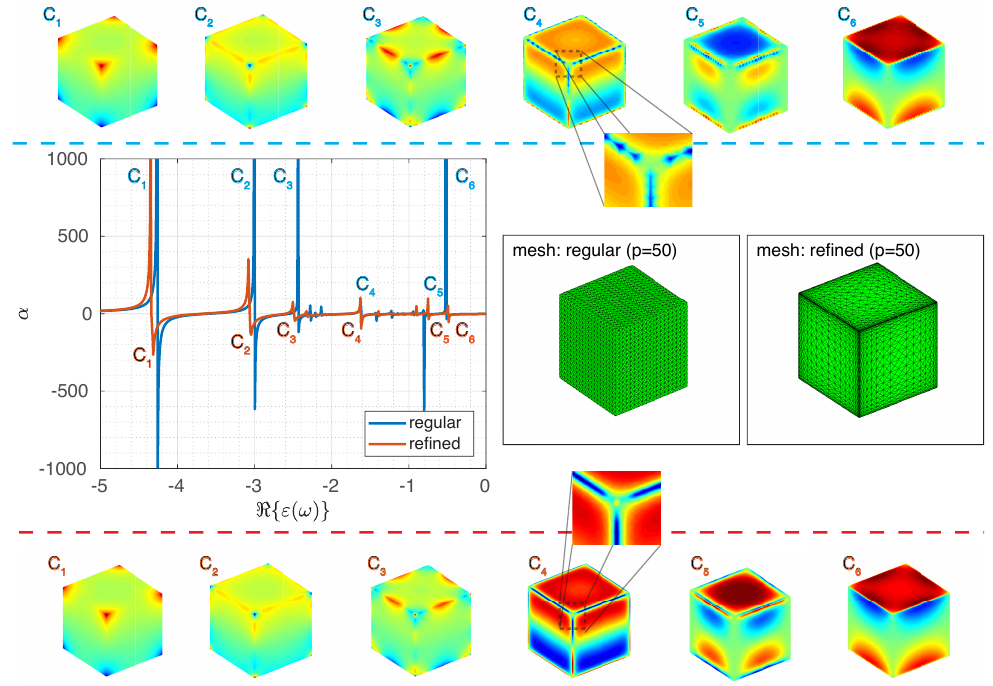
Figure 3. As in Figure 2, the absolute value of the polarizability at the ε ∈ [ − 5,0 ] domain for the sharp cube ( p = 50). The color figures at the top depict the surface potential of the six most pronounced resonances C 1 – C 6 , extracted with a regular mesh, while the bottom figures are extracted with a refined mesh. The C 4 resonance is actually different between the two mesh setups (inset sketches top and bottom). Note also the disagreement of the C 3 resonance between the smooth case (Figure 2) and